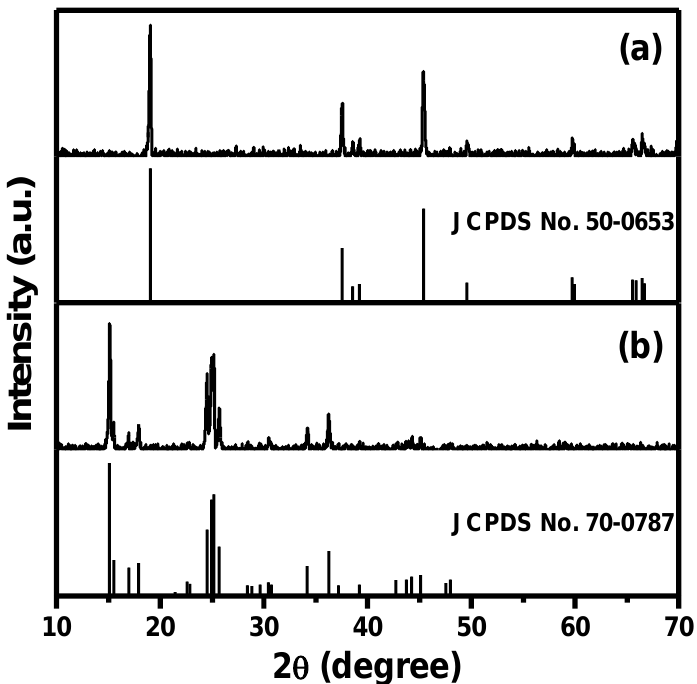
Figure 2. PXRD patterns of ( a ) the obtained LiCoO 2 after the refluxing process in Figure 1, ( b ) the synthesized Co(NH 3 ) 6 ·Cl 3 after the ammonia solution treatment in Figure 1.